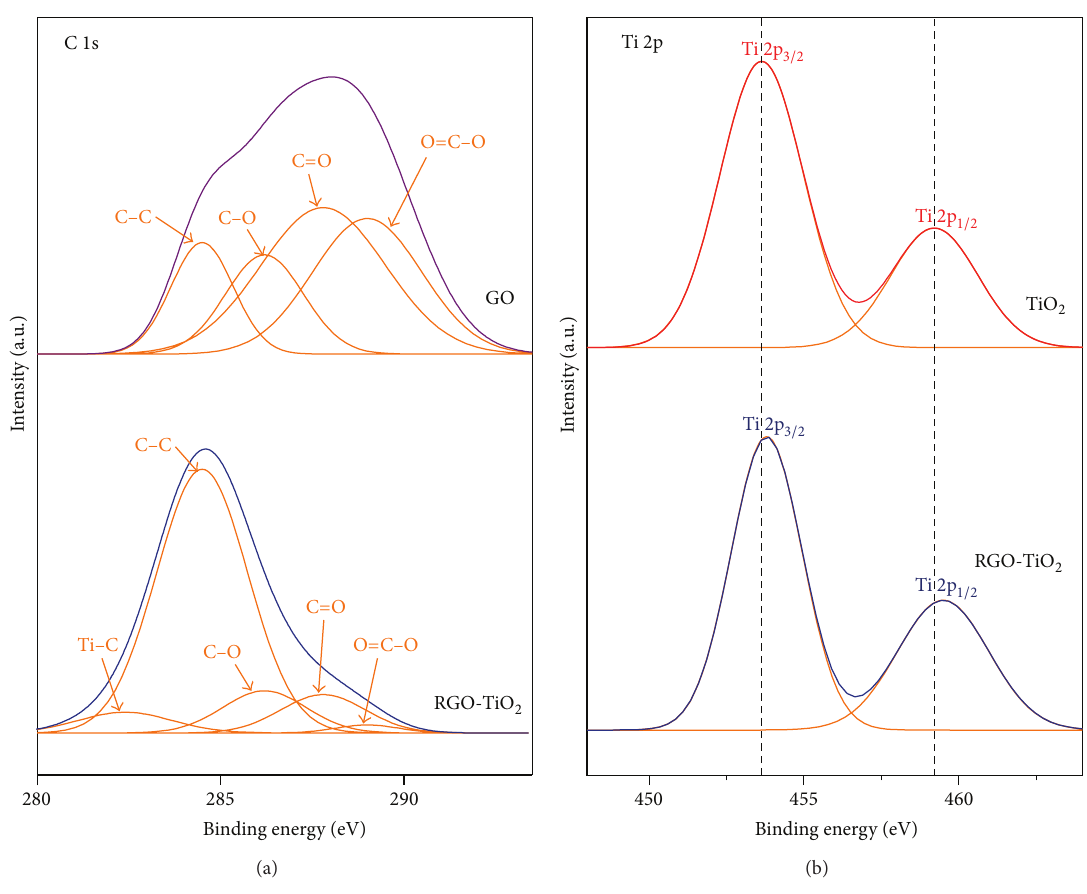
Figure 5: XPS spectra of (a) C 1s of GO and RGO-TiO 2 composite and (b) Ti 2p of TiO 2 and RGO-TiO 2 composite.